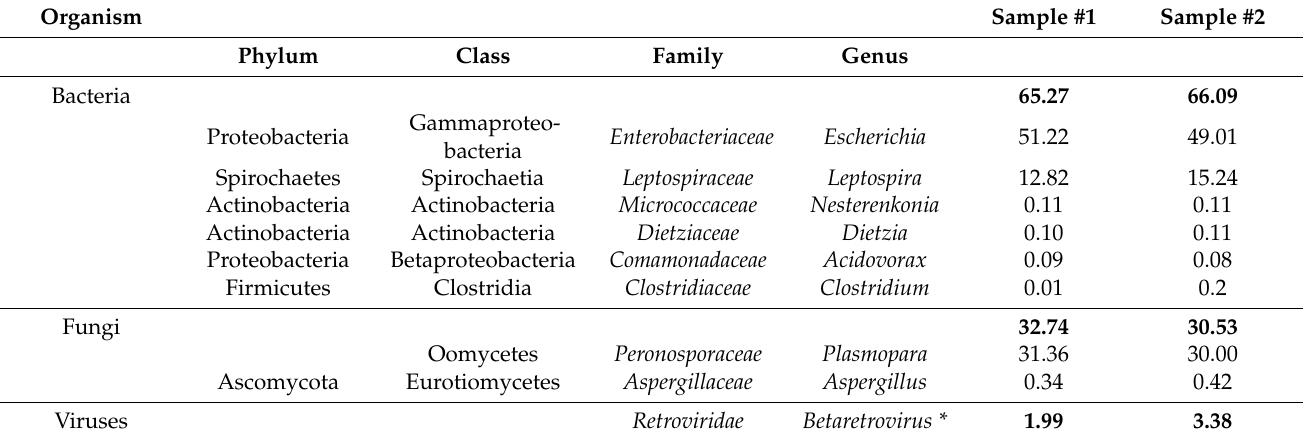
Table 2. Kidney-associated microbiota in Artebius spp. from Grenada, West Indies, expressed as relative estimated abundance